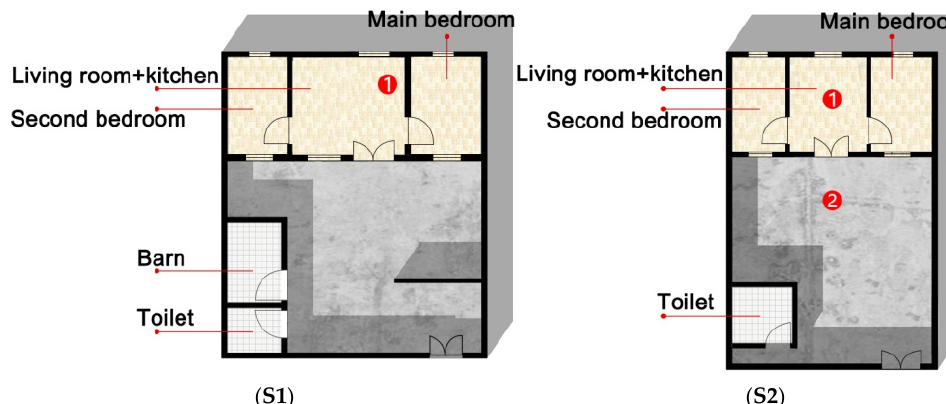
Figure 12. Arrangement of the instruments during summer.